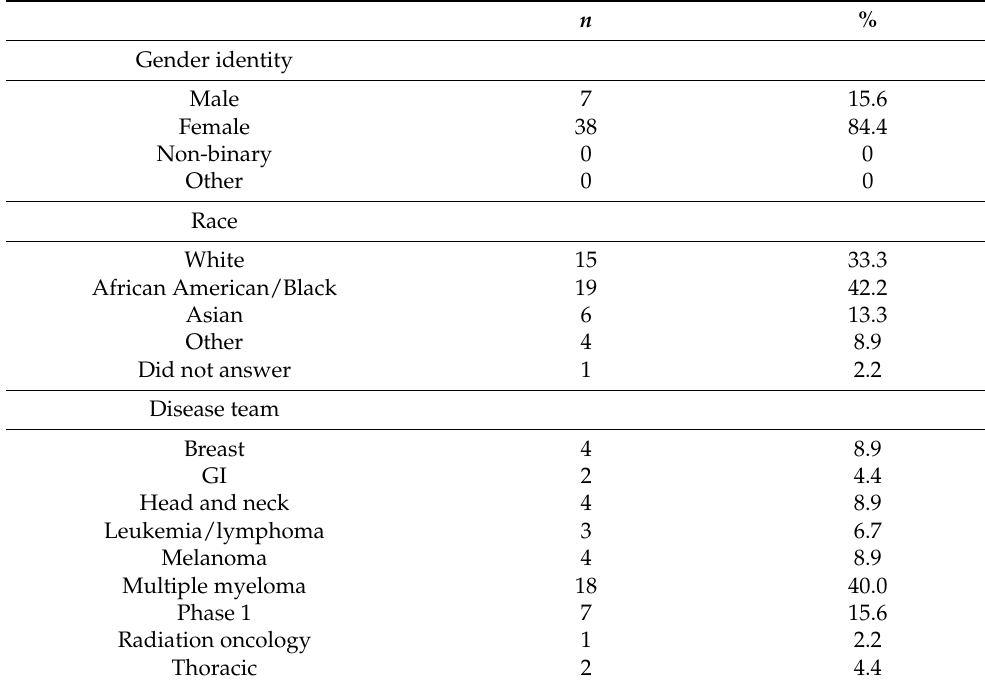
Table 1. Demographic characteristics ( n = 45).